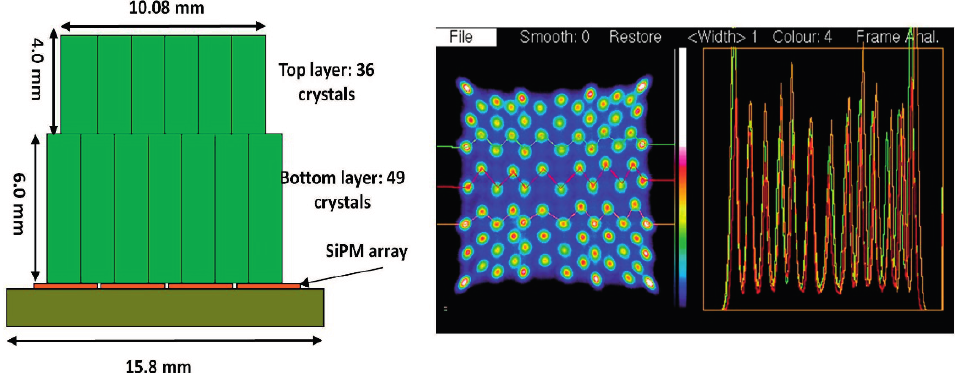
Figure 7. Detector with SensL S-series SiPM and LYSO crystal block with 36 crystals in the top layer and 49 in the bottom layer and the response pattern with profiles through rows of crystals showing that they are well resolved.